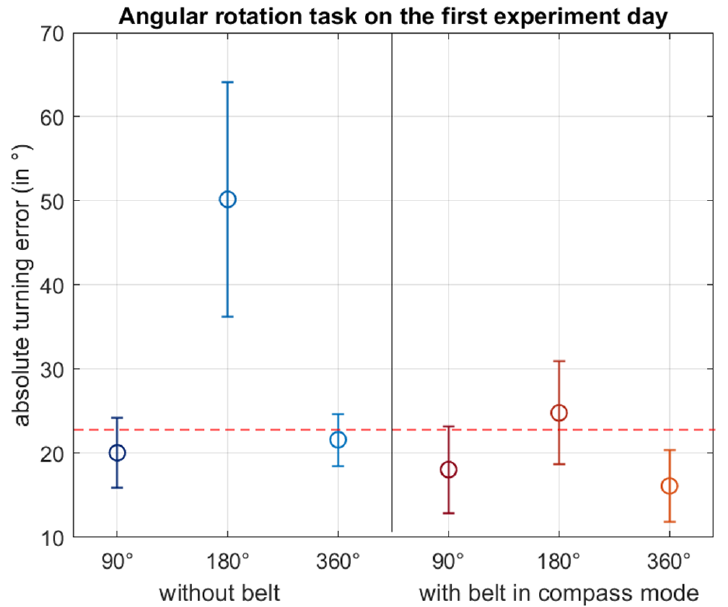
Figure 9. This figure shows the absolute turning errors of the participants during the angular rotation task on the first experiment day. The errors are subdivided into the three turning degrees 90 ◦ , 180 ◦ and 360 ◦ . Turns performed without the belt are displayed in the left half and turns performed with the belt in compass mode are depicted in the right half of the diagram. The circles indicate the mean and the whiskers the SEM. The red dotted line at 22.5 ◦ indicates the angular range that the correctly activated single vibromotor covers before the vibrating signal moves to the neighbouring vibromotor.